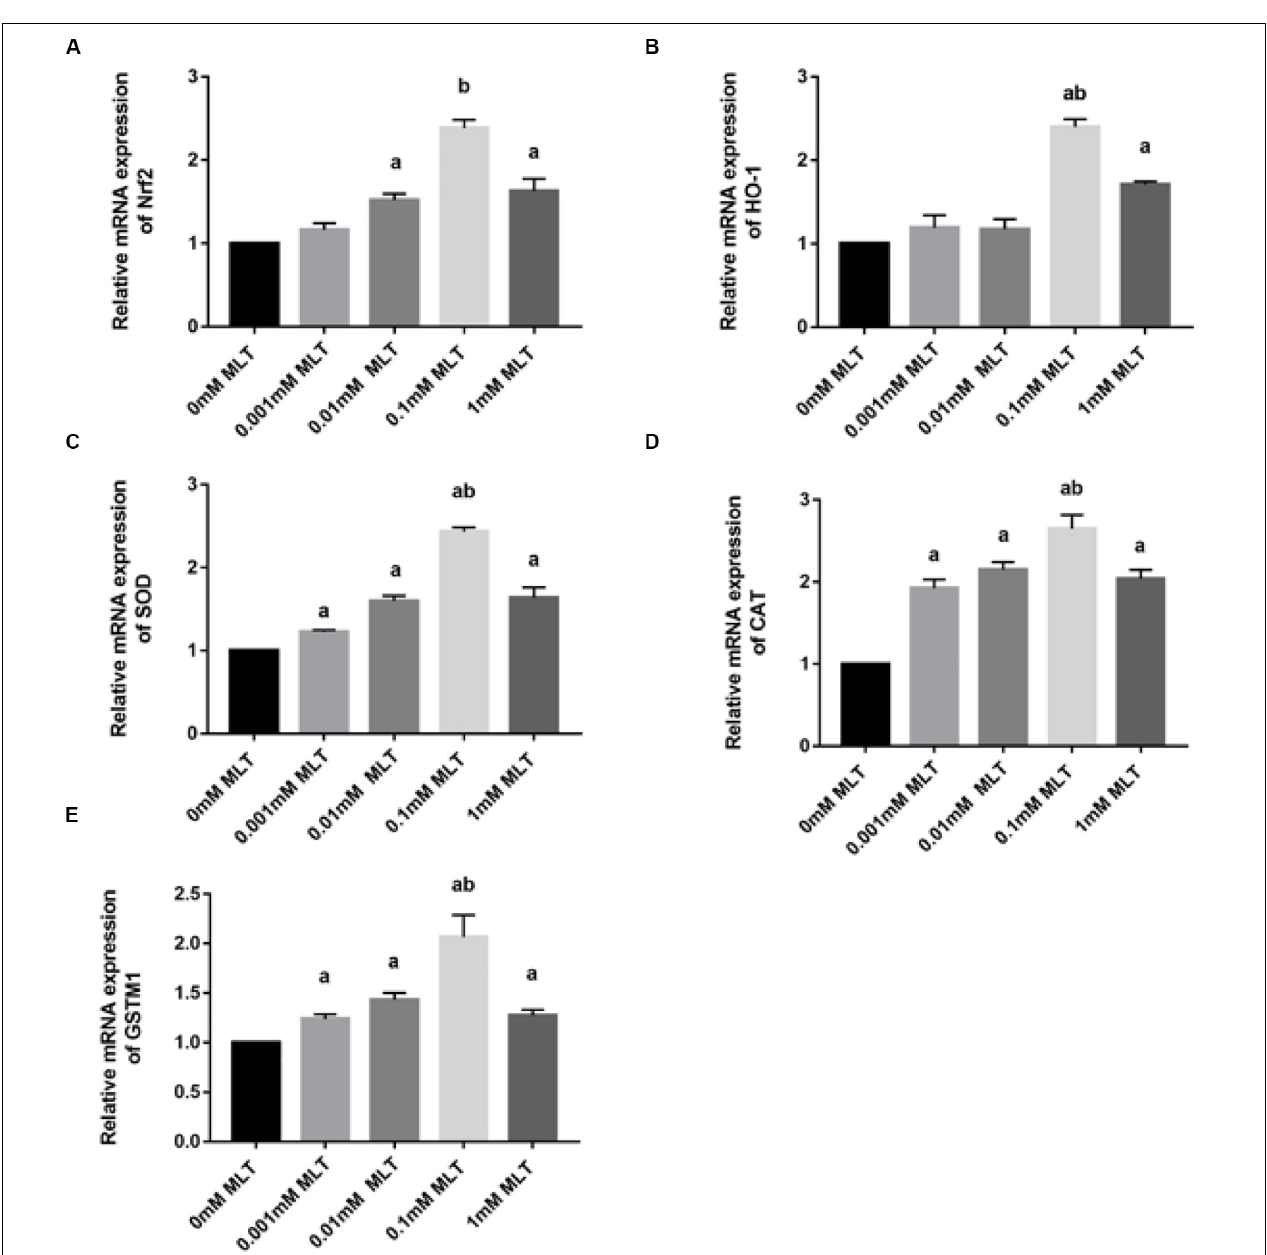
FIGURE 5 | MLT affects Nrf2 and its related gene expressions in cryopreserved OTs. (A) Relative mRNA expressions of Nrf2 in each MLT-(un)treated group. (B) Relative mRNA expressions of HO-1 in each MLT-(un)treated group. (C) Relative mRNA expressions of SOD in each MLT-(un)treated group. (D) Relative mRNA expressions of CAT in each MLT-(un)treated group. (E) Relative mRNA expressions of GSTM1 in each MLT-(un)treated group. Data are shown as the mean ± SEM. a P < 0.05 compared with the 0-mM MLT-untreated group; b P < 0.05 compared with the MLT-treated